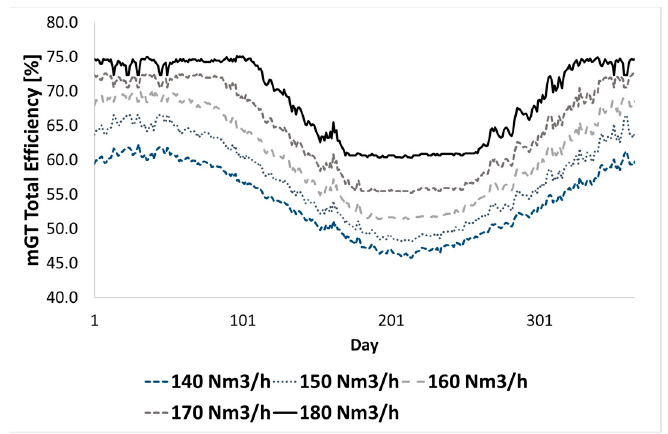
Figure 16 . The recovery efficiency for upgrading units of various sizes. Figure 16. The recovery efficiency for upgrading units of various sizes. Energies 2019 , 12 , x FOR PEER REVIEW